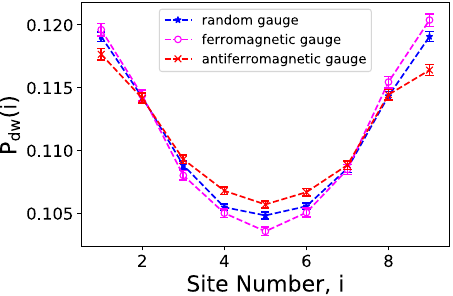
Fig. 6 Top: Numerically calculated domain-wall distribution assuming thermal equilibrium in the presence or absence of a transverse fi eld for experimentally realistic parameters. Bottom: same as top but with mid-point value subtracted to allow direct comparison, inset is difference between the two curves. Both data were taken using the same 10 5 random noise realizations. Error bars are standard error, and this plot uses experimentally realistic ¼ 0 : 24 and T ¼ 15 mK ¼ 0 : 31 GHz . parameters σ ζ T Table 1. Summary of different noise measurement techniques and the results obtained from them. Measurement technique